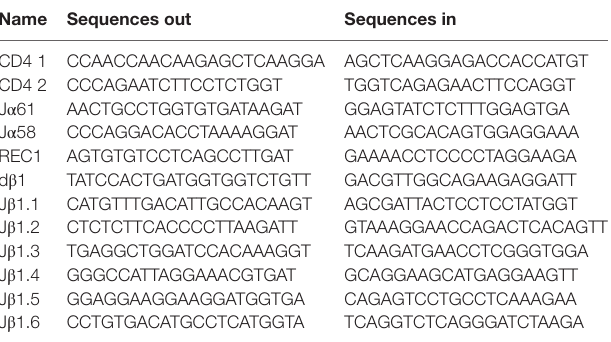
TaBle 1 | Outer and inner primers for T-cell receptor excision circle